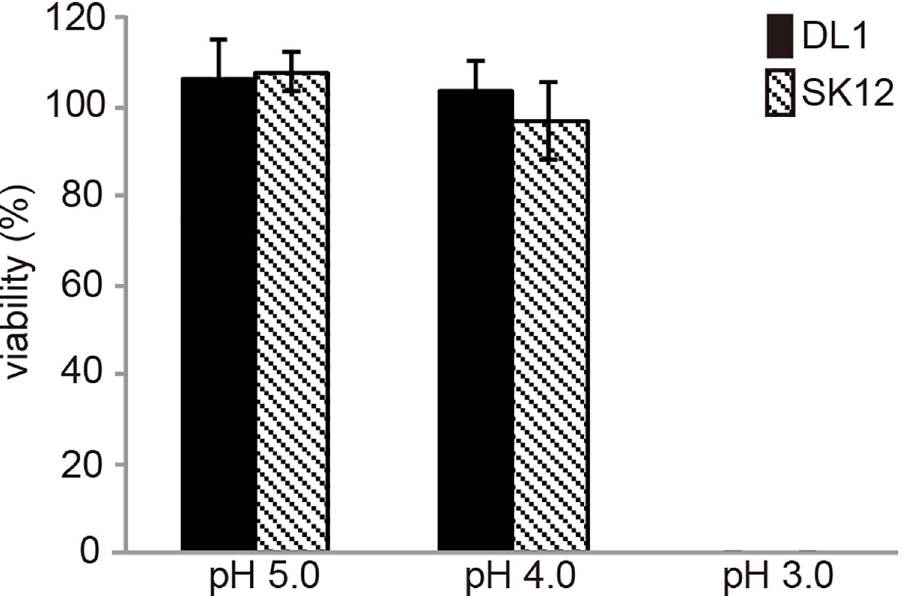
Fig 2. Survival of Streptococcus gordonii under acidic conditions. Streptococcus gordonii DL1 and SK12 were cultured in RPMI media of varied pH conditions for 2 h at 37˚C. Percent survival was calculated based on number of colony forming units of bacteria in acidic conditions compared to that of bacteria cultured in medium at pH 7.0. n = 4; mean with standard error is shown. Statistical differences in the means of obtained values were evaluated via unpaired t